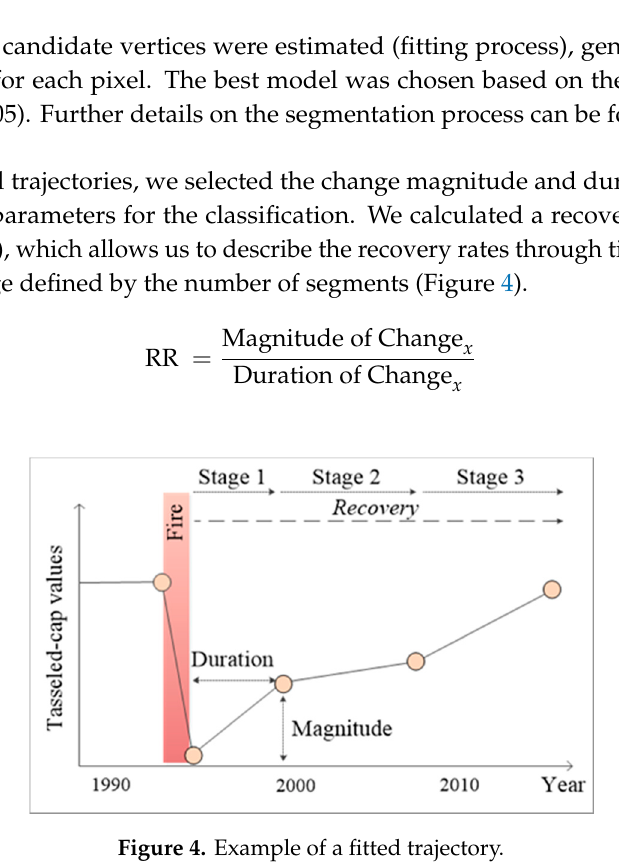
Table 1. List of variables used in the regression analysis.